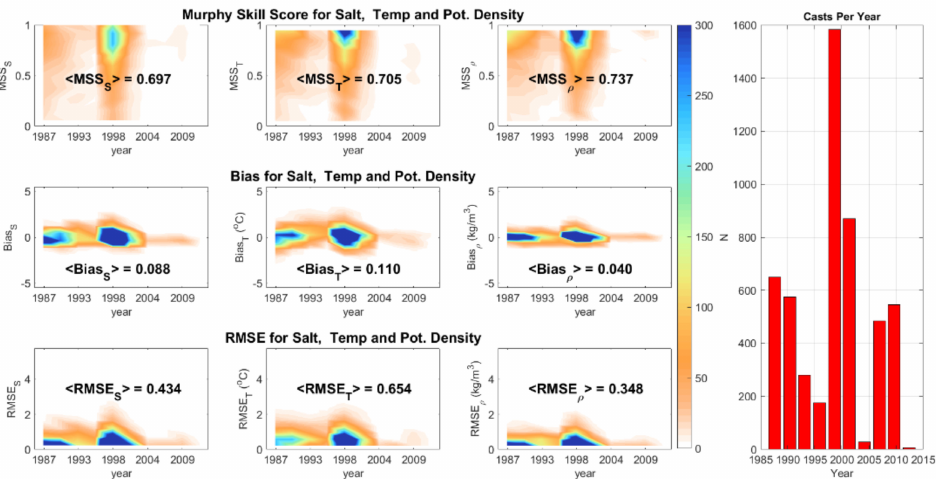
Figure 8. Comparison between observed and modelled θ /S profiles from R/V CTD, XBT and Bottles for the period 1986–2013. Positions of casts (shown in Figure 1) are inside the computational grid. For all statistical metrics that are presented (Murphy Skill Score, Root Mean Square Error and Bias skill) < > denotes mean